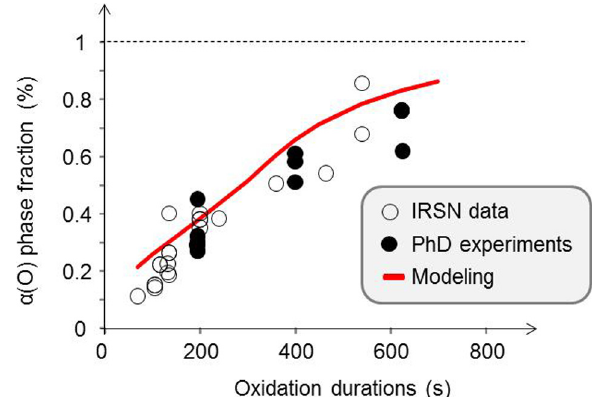
Fig. 7. Measured a (O) average phase fraction versus modeling using numerically determined oxygen diffusion coef fi cient in the a + b